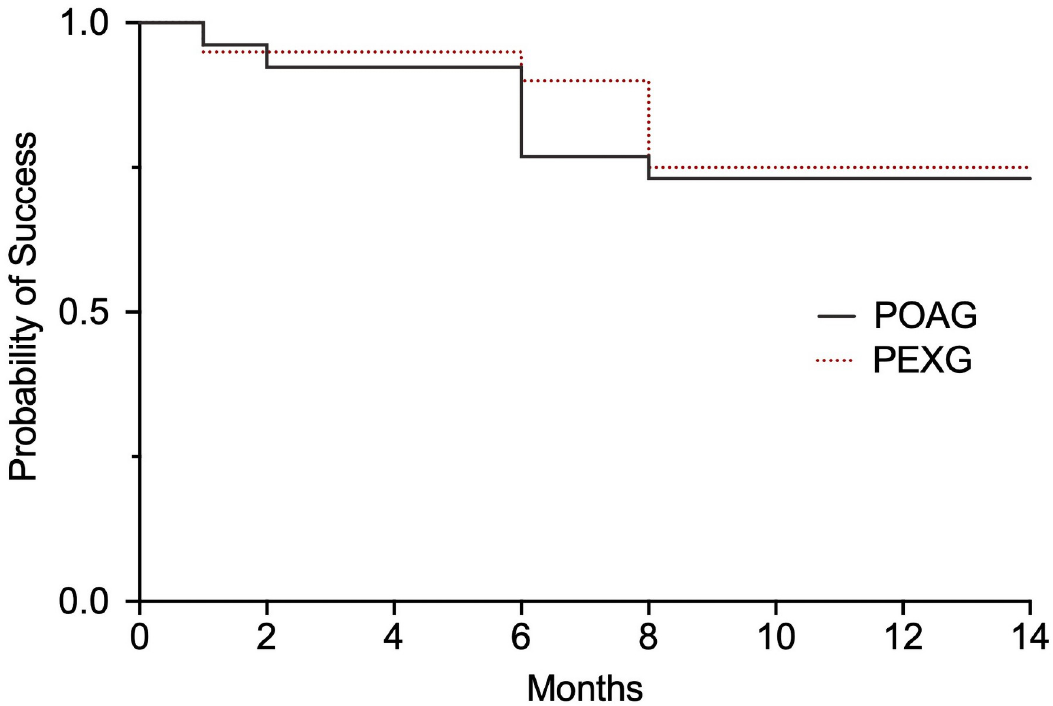
Fig 5. Kaplan-Meier survival curves. Kaplan-Meier survival curves for complete success. POAG = primary open angle glaucoma; PEXG = pseudoexfoliation glaucoma.